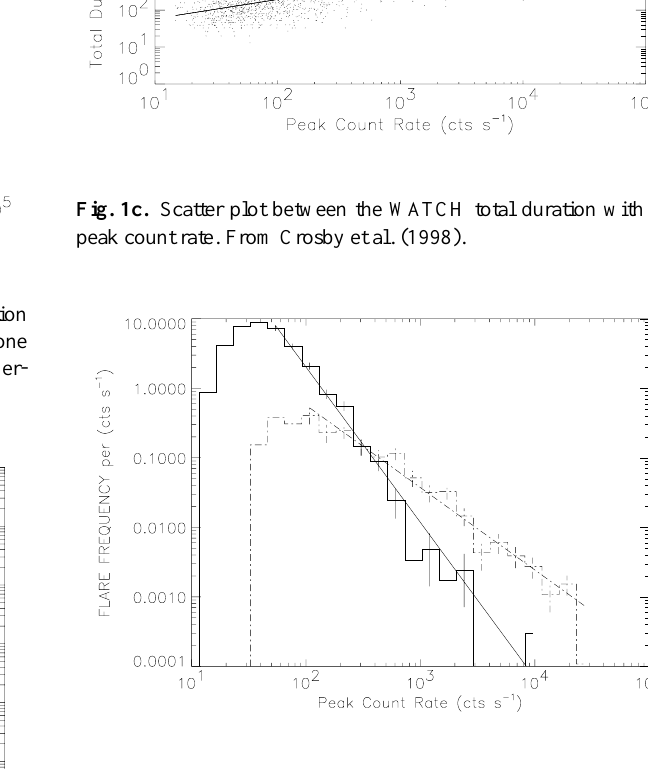
Fig.12. Scatter plots between the (1) total duration, (2) rise time and Fig.10. The frequency distribution of the WATCH flare peak count (3) decay time with the peak count rate with the following slopes (s) rate for the total observing period (top) well-represented by a power- and correlation coefficients (cc): (1) s= 0.52+/-0.07 and cc= 0.61, (2) s= 0.46+/-0.06 and cc= 0.50, (3) s= 0.57 +/- 0.06 and cc= 0.62. law above the turn-over at 50 c/s (1251 events) with a slope α = -1.58 Fig. 1d. The frequency distribution of the WATCH peak count rate +/- 0.02. The frequency distribution of the WATCH peak count rate for as function of duration interval. The steeper slope refers to events differentsub-groupsofevents(bottom).Thesteeperslope( α =-2.17+/- that have durations less than 200s and the flatter slope to events that found between the elapsed time 4 T and the size of the event. 0.07) refers to events with duration less that 200 seconds (full line) and have durations greater than 800s. From Crosby et al. the flatter slope ( α = -1.15+/-0.05) to events that have durations greater than 1000 seconds (dashed curve)